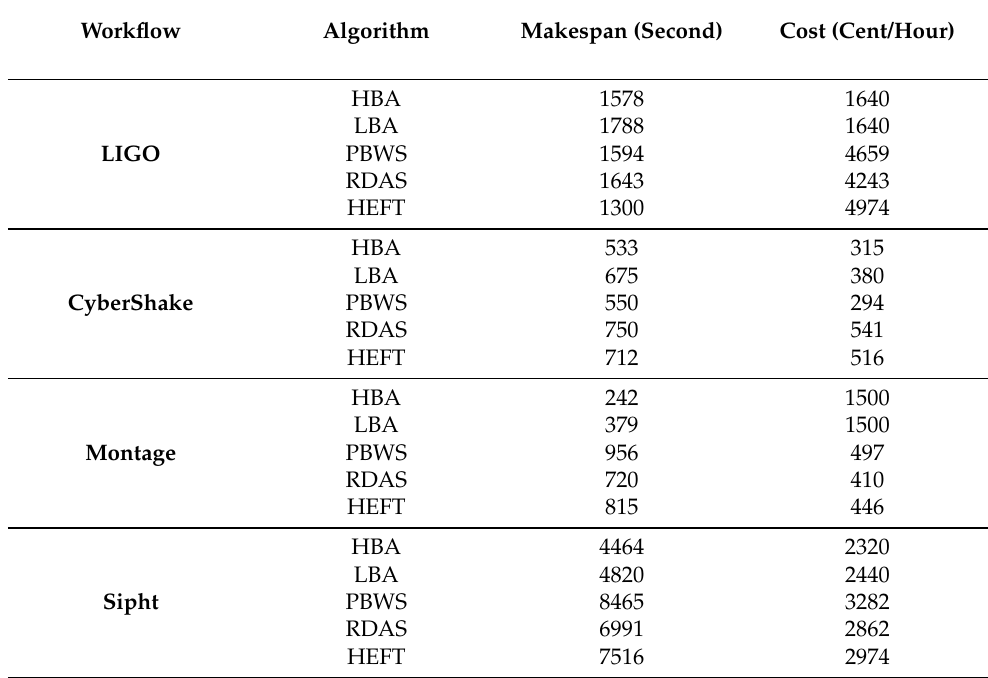
Table 3. Comparison of the experimental